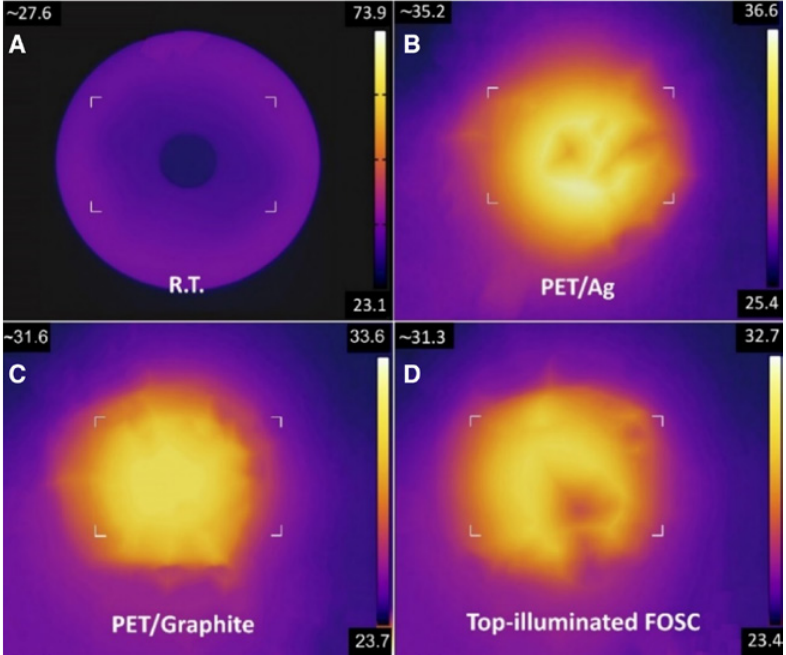
Figure 6: Thermal images taken with an IR camera for comparing the heat-insulation properties. (A) Thin metal object. (B) PET/Ag substrate. (C) PET/Graphite substrate. (D) Top-illuminated